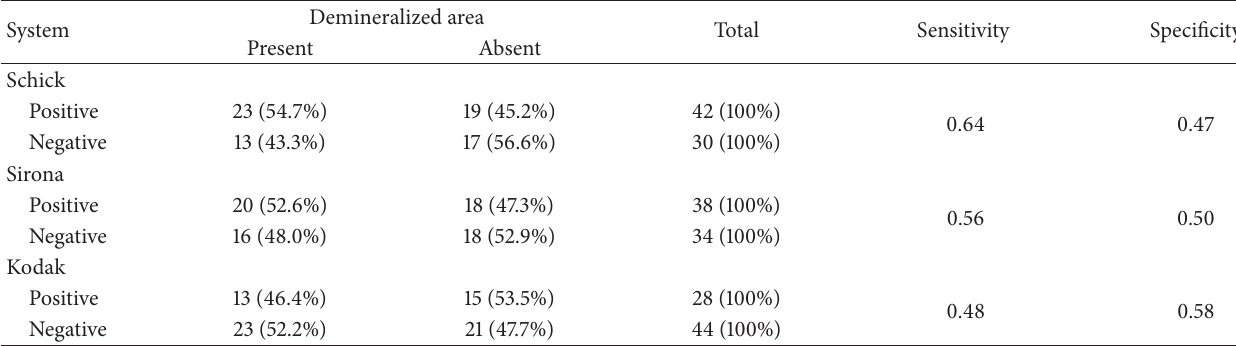
Table 3: Sensitivity and specificity of digital radiographic systems in detection of demineralized areas. Demineralized area System